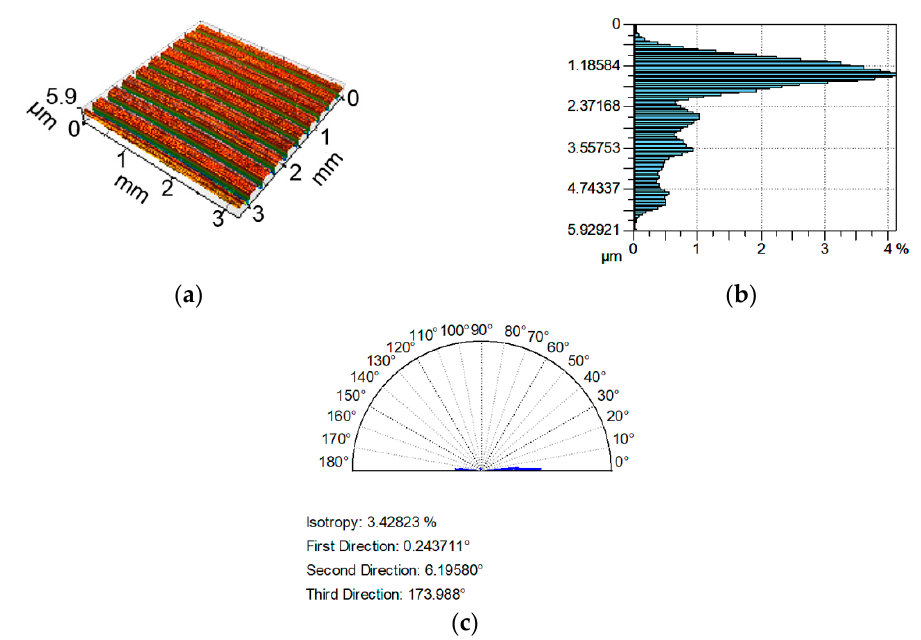
Figure 4. Isometric view ( a ), ordinate distribution ( b ), and directionality plot ( c ) of surface texture after milling.